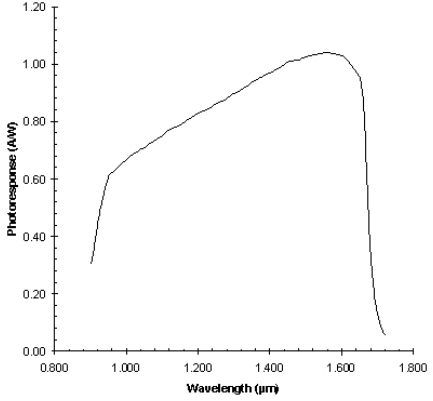
Figure 7. Spectral response of an InGaAs